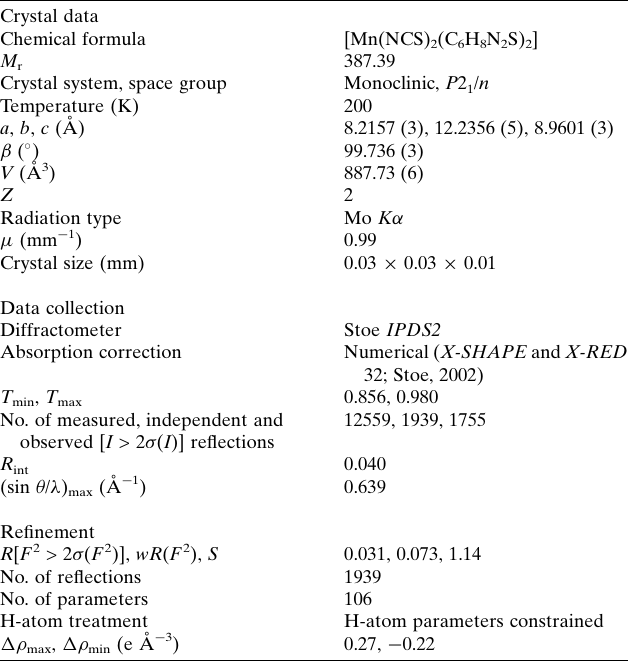
Table 3 Experimental details. Crystal data Chemical